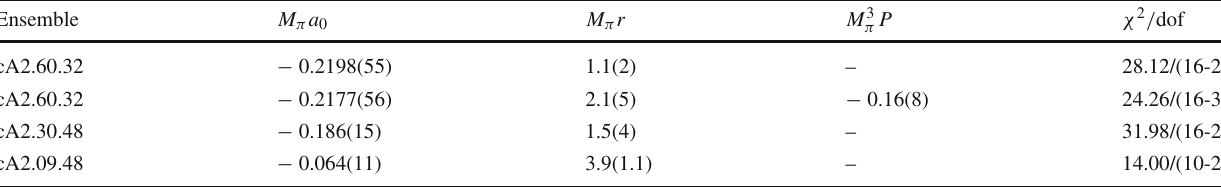
Table 3 Two-particle fits to the standard effective range expansion (ERE) model in Eq. 7